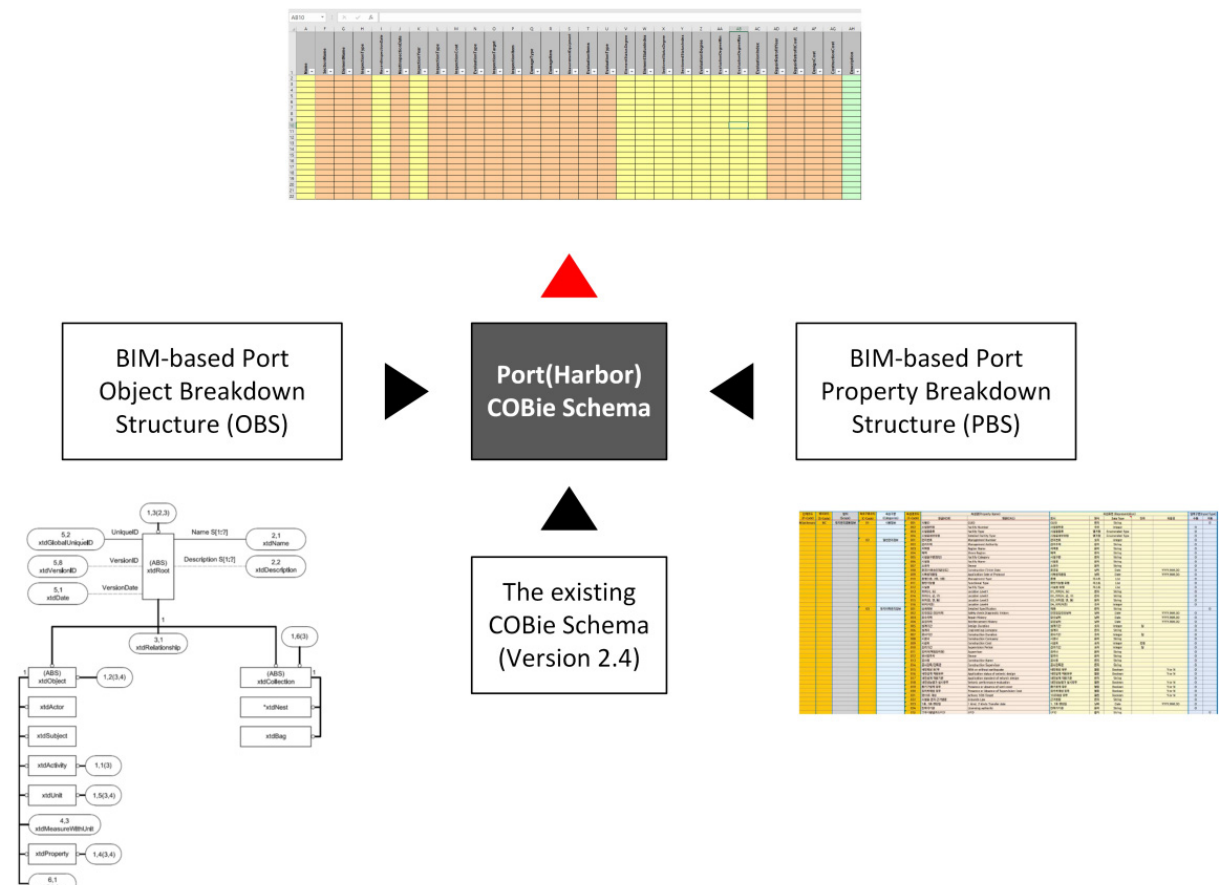
Figure 5. The references for developing the port COBie